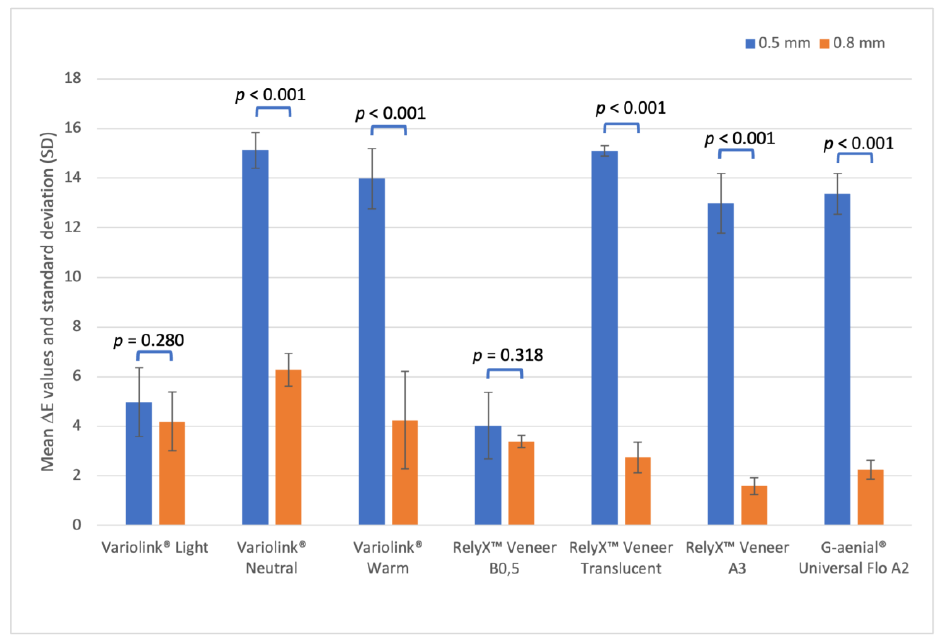
Figure 2. Mean  E values and standard deviation (SD) bars obtained for bonded ceramic samples Figure 2. Mean ∆ E values and standard deviation (SD) bars obtained for bonded ceramic samples